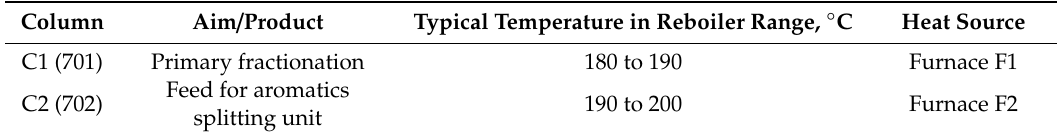
Figure 3. Part of feed pretreatment in the aromatics fractionation process. Table 1. Basic parameters of feed pretreatment